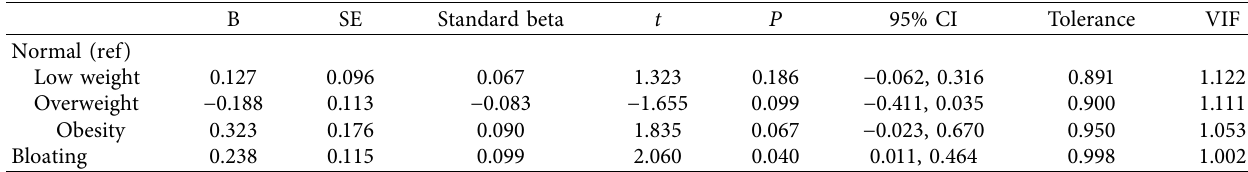
Table 5: Multiple linear regression of BTP intensity.